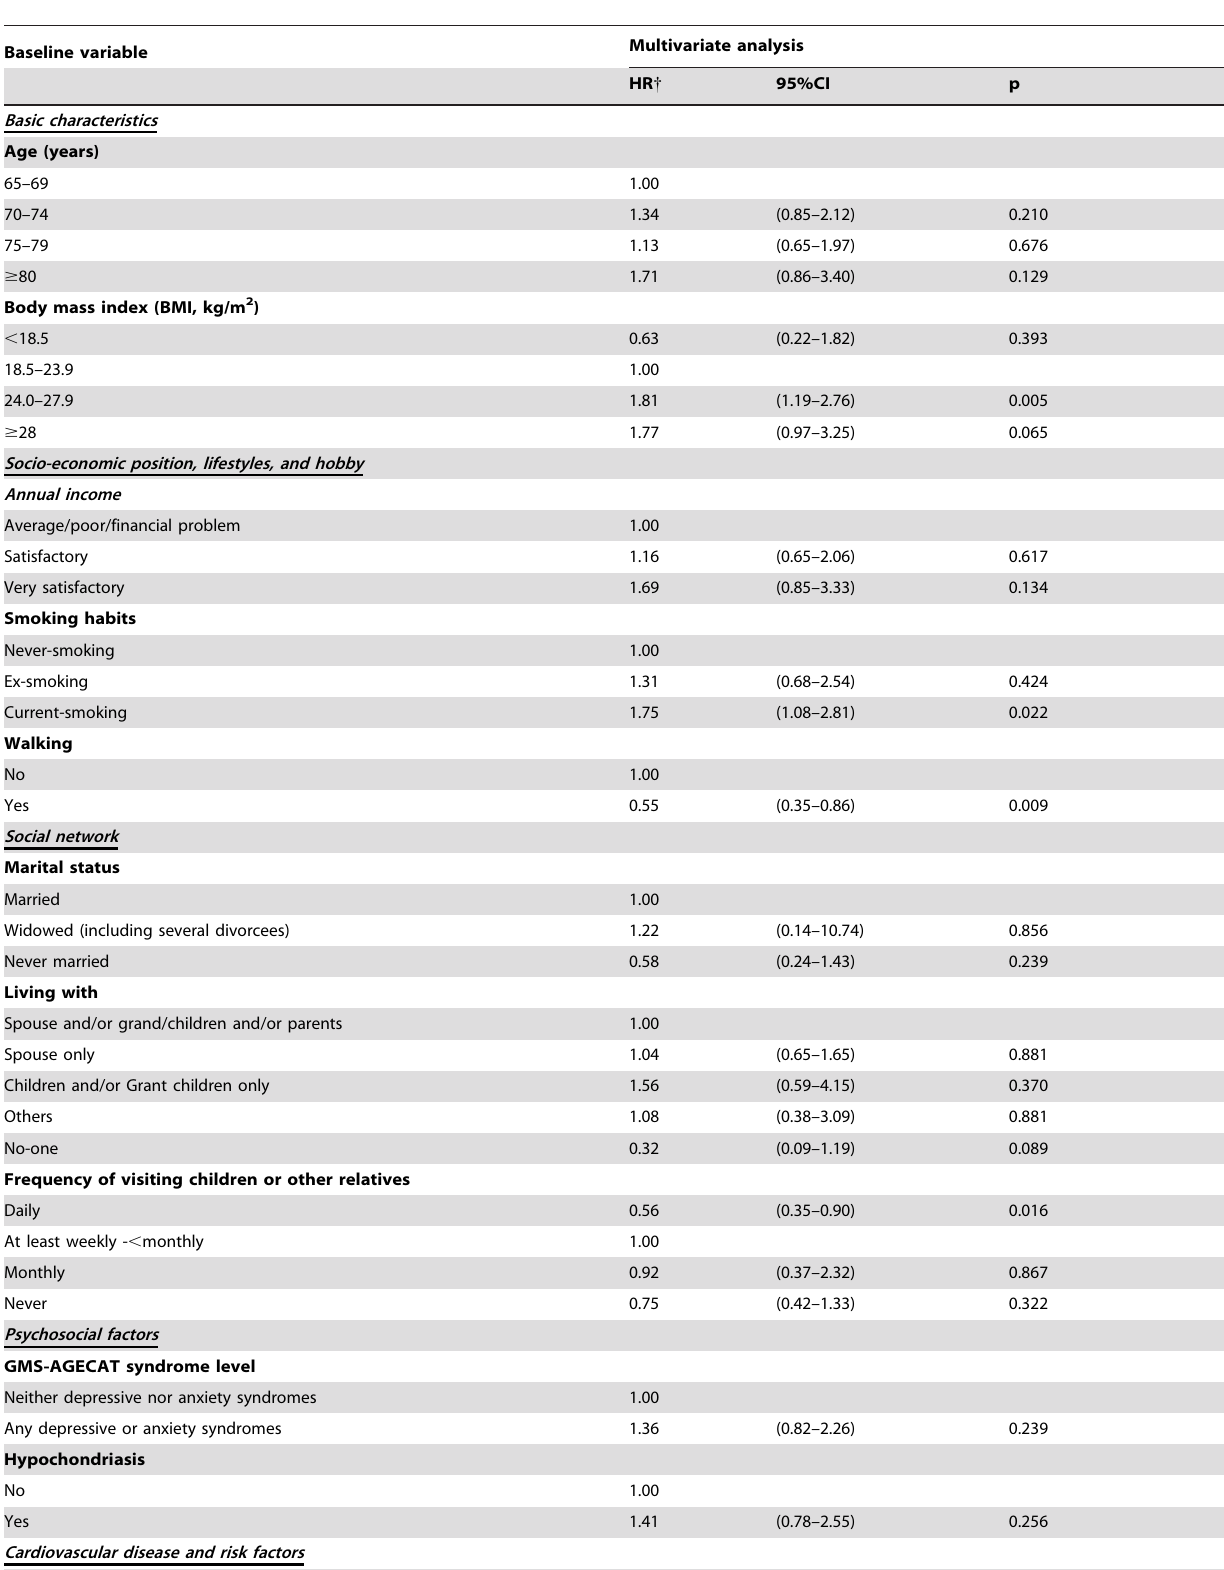
Table 3. Multivariate analysis for predictors of incident diabetes in older people - Hefei cohort study,